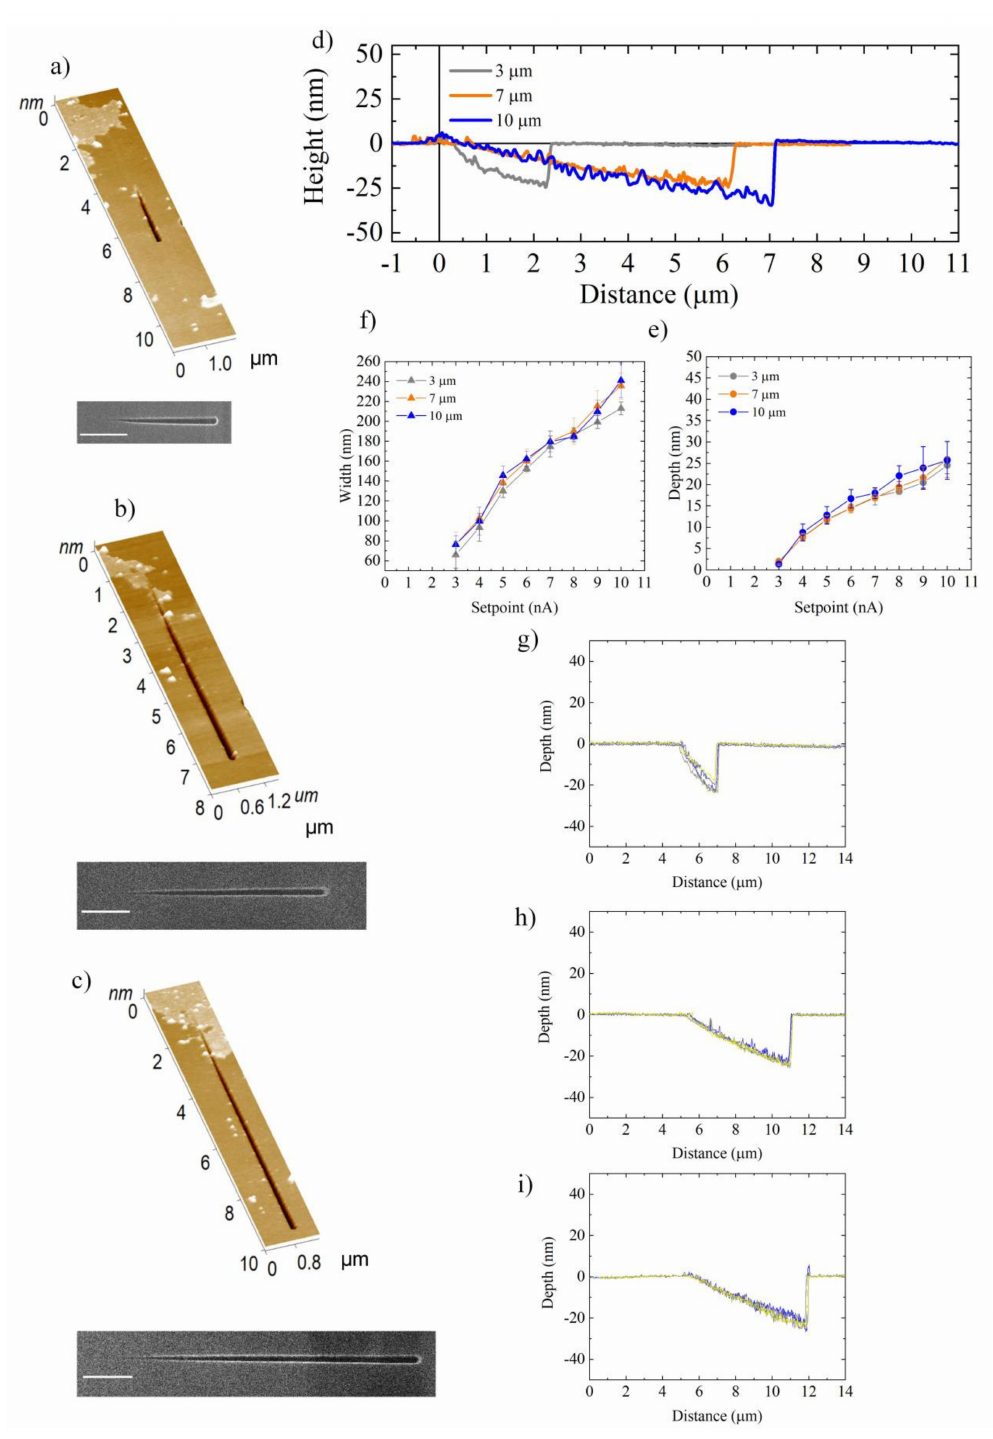
Figure 7. Results of analysis performed on nanochannels with linearly variable depth profile trans- ferred onto the SiN substrate by means ICP etching. SEM and SensHeight AFM 3D-topography of nanochannels with linearly variable depth profile 3 ( a ), 7 ( b ), and 10 µ m ( c ) long. The scale bars in the SEM images are 1 µ m long. ( d ) Superimposition of representative cross-section profile of nanochannels 3, 7, and 10 µ m long ( e ) Depth and ( f ) width values in correspondence to different set- point; each mean value was calculated on 20 points. ( g – i ) show the superimposition of five different cross-section curves in the case of nanochannels 3 ( g ), 7 ( h ), and 10 µ m ( i ) long. Data reported in ( e , f ) were statistically significant for p <